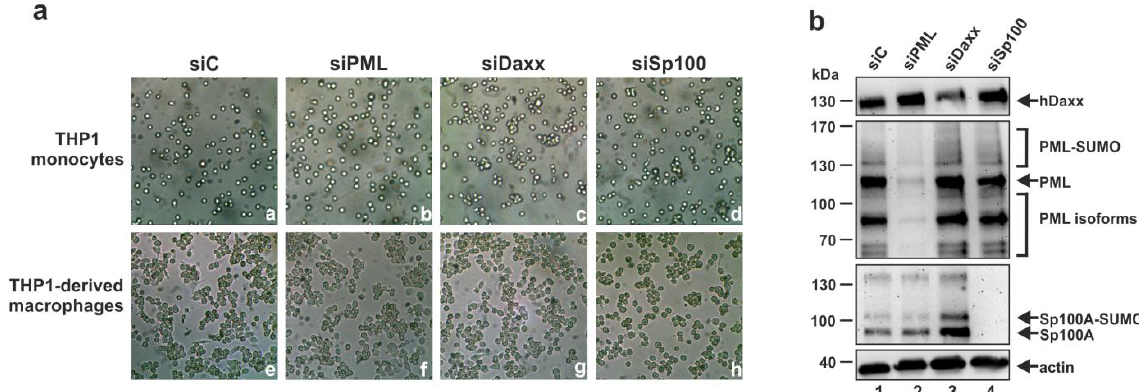
Figure 3. Depletion of PML, hDaxx or Sp100 does not prevent differentiation of THP-1 monocytes to THP-1 derived macrophages. ( a ) THP-1 monocytes were treated with PMA for 48 h followed by comparison of the morphology of THP-1 derived macrophages and THP-1 monocytes by transmitted light microscopy; ( b ) Verification of the knockdown of PML, hDaxx and Sp100 after differentiation of THP-1 monocytes. Cell lysates derived from the respective THP-1-derived macrophages were analyzed by Western blotting for PML, hDaxx and Sp100 expression. Upper panel: Staining of hDaxx protein levels of siC- (lane 1), siPML- (lane 2), siDaxx- (lane 3) and siSp100-transduced cells (lane 4) using a rabbit monoclonal anti-hDaxx antibody. Middle panels: Detection of various SUMOylated and non-SUMOylated isoforms of PML and Sp100 with the rabbit polyclonal anti-PML antibodies A301-167A + A301-168A and the anti-Sp100 rabbit serum GH3, respectively. Lower panel: β-actin detection was included as internal loading control.